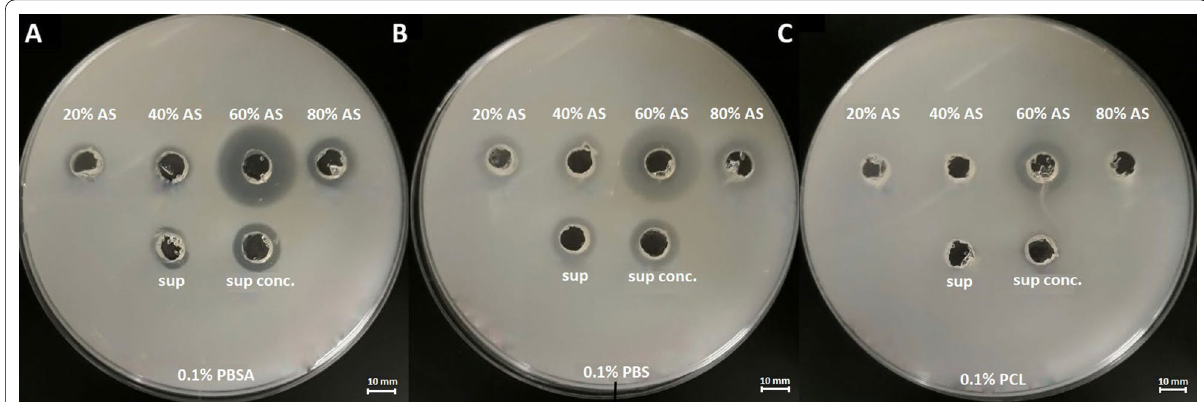
Fig. 1 Comparison of enzymatic activity in a plate assay of cell-free broth (sup), concentrated cell-free broth (sup conc.) and fractions precipitated with (NH 4 ) 2 SO 4 (20, 40, 60 and 80% AS). The largest halo zone was observed in the fractions saturated with AS up to 60%. All fractions were applied on MM medium supplemented with A 0.1% PBSA; B 0.1% PBS; C 0.1%